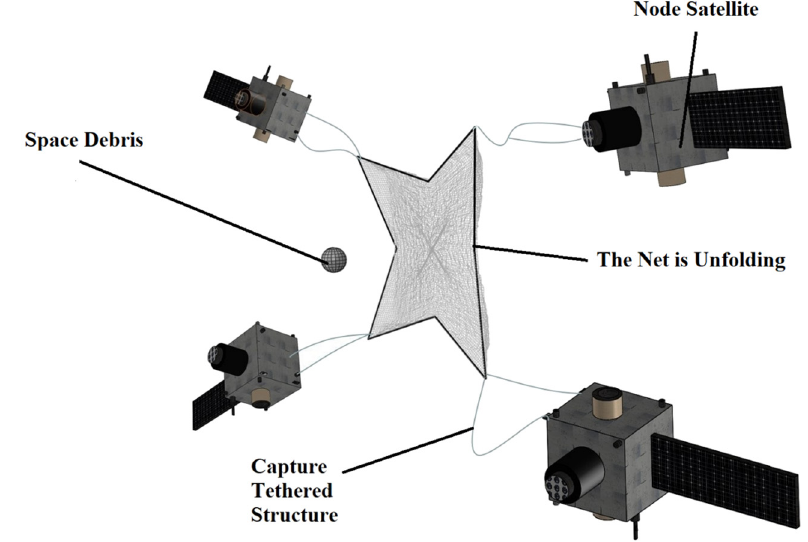
Figure 7: Space debris removal by the micro/nano joint satellite ( unfolding of the net )